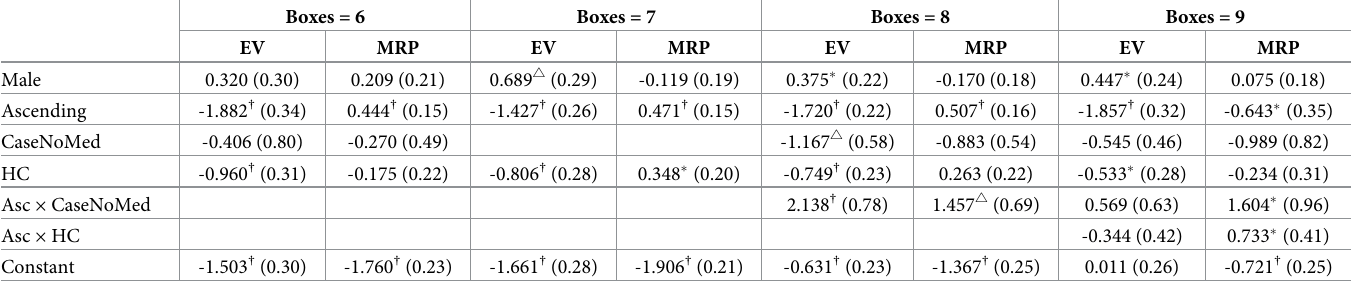
Table 3. Stratum-specific multinomial regression models for the probabilities of agreement with EV and MRP. Estimated parameters (std errors). HC is equal to one for healthy controls and CaseNoMed is equal to one for non medicated OCD patients, so that the reference group is that of medicated OCD patients. Baseline outcome is no agreement with either model. � :p < 0.1; 4 :p < 0.05; † :p <